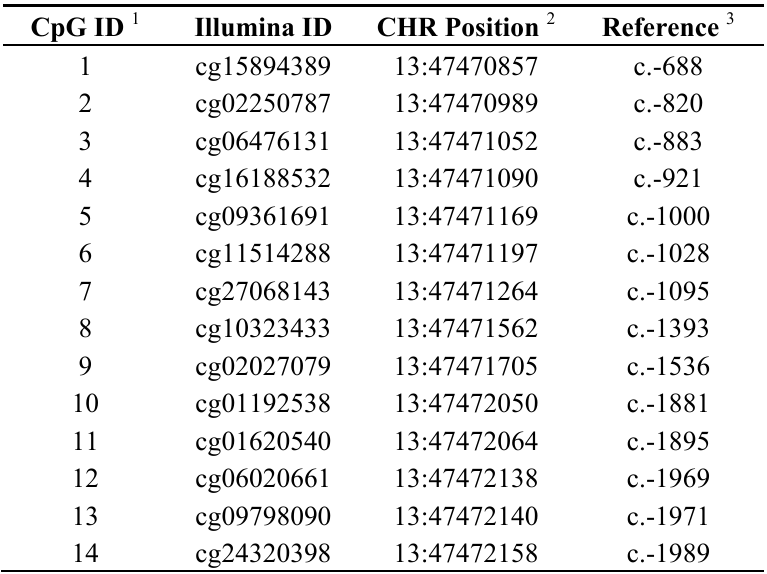
Table 1. Information of the selected CpG sites for HTR2A